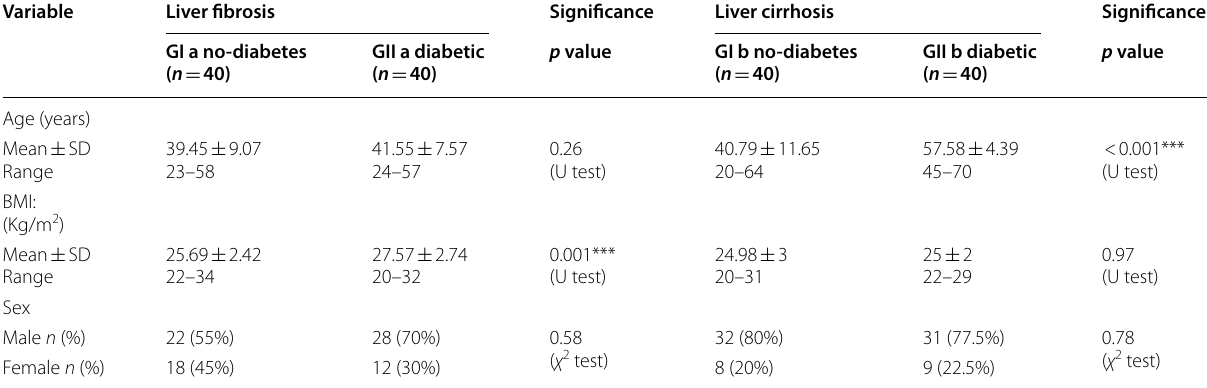
Table 1 Demographic characteristic regarding fibrosis degree (fibrosis versus cirrhosis) in non‑diabetic and diabetic group